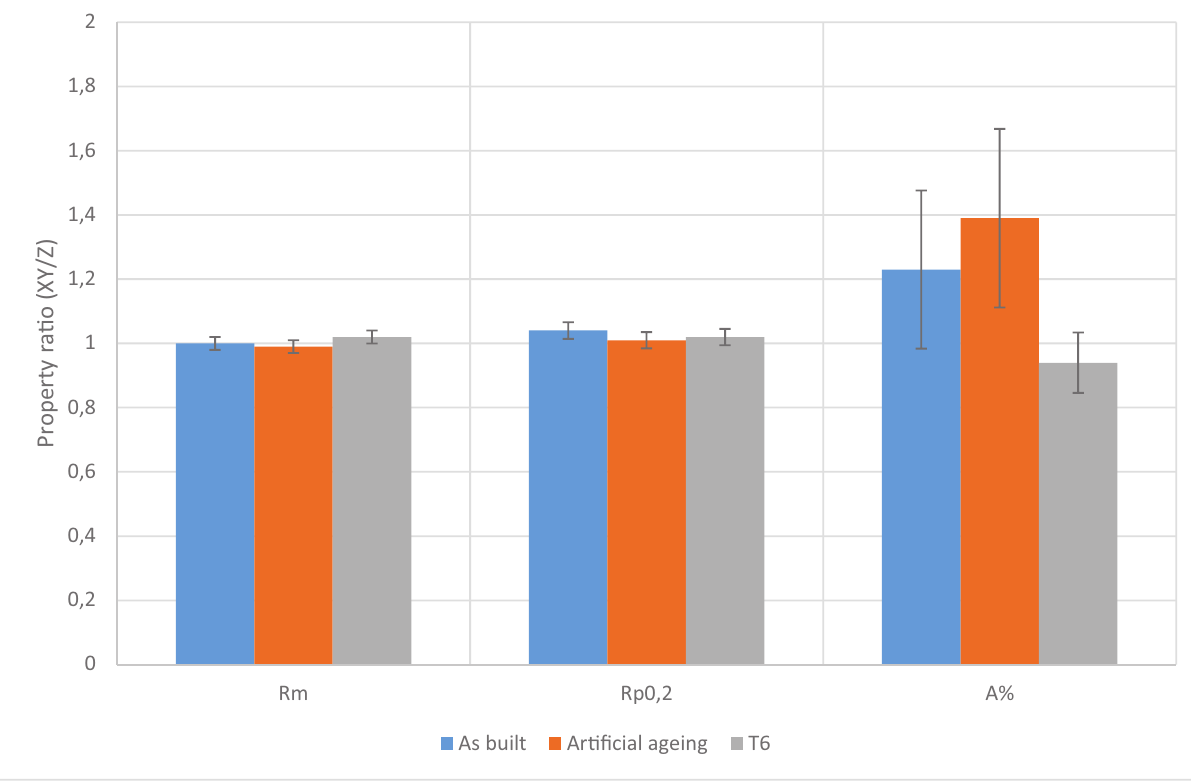
Fig. 8. Anisotropy of the static mechanical